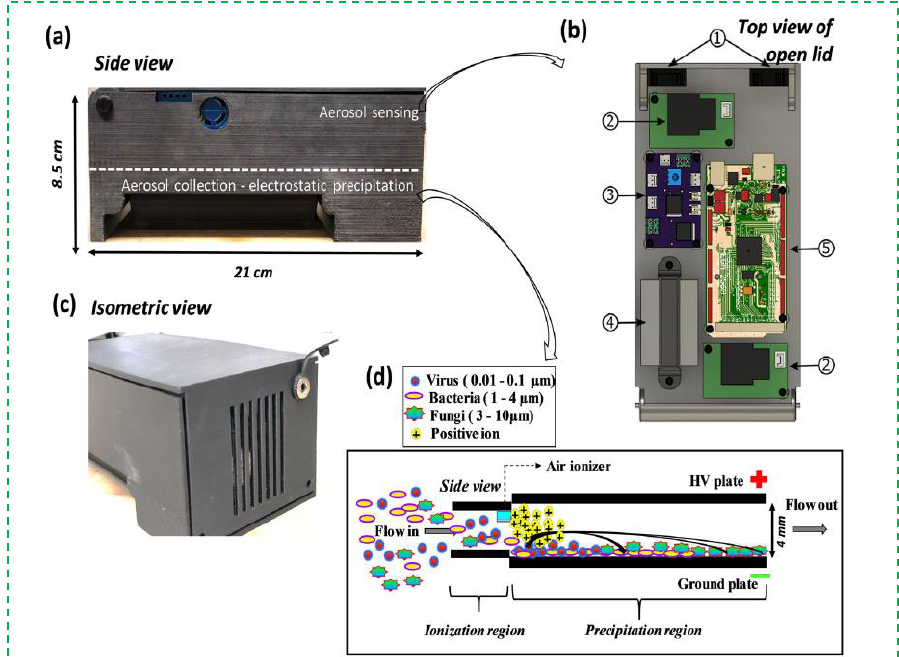
Figure 1. The electrostatic sedimentation for collection of bacterial bioaerosols. ( a ) side view of the device; ( b ) the aerosol sensing components; ( c ) isometric view of the device; ( d ) schematic representation of the side view of the electrostatic precipitator situated at the bottom of the device. Reprinted with permission from ref. [35]. Copyright 2021 Taylor & Francis.